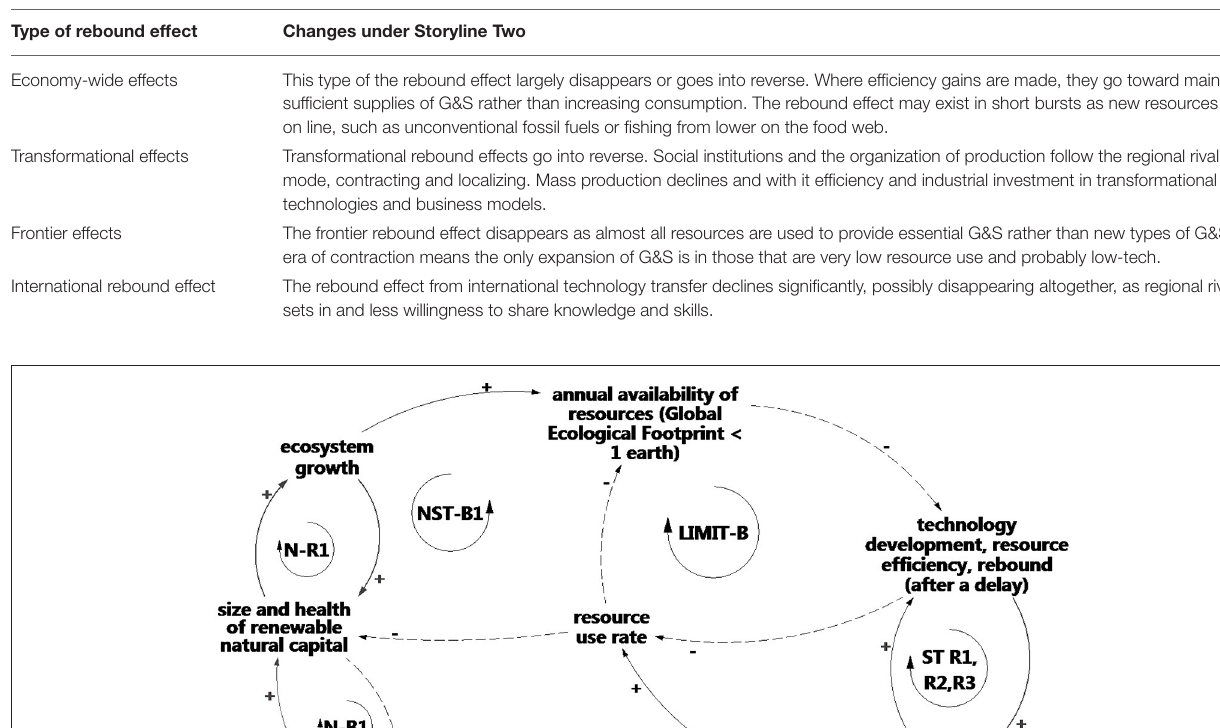
TABLE 5 | Storyline two changes in four types of macro-level rebound effects.